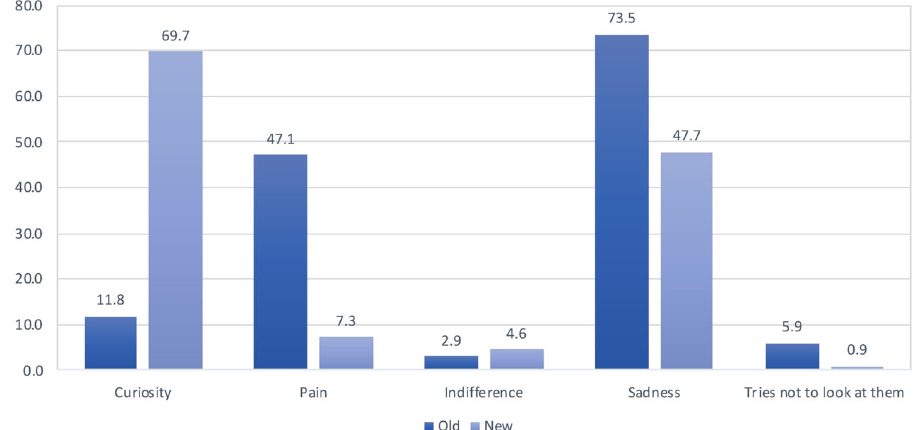
Fig. 10 Local community. Feelings upon seeing the ruins. Note: The sum of the percentages is not equal to 100% due to the fact that each person was able to respond to several options.